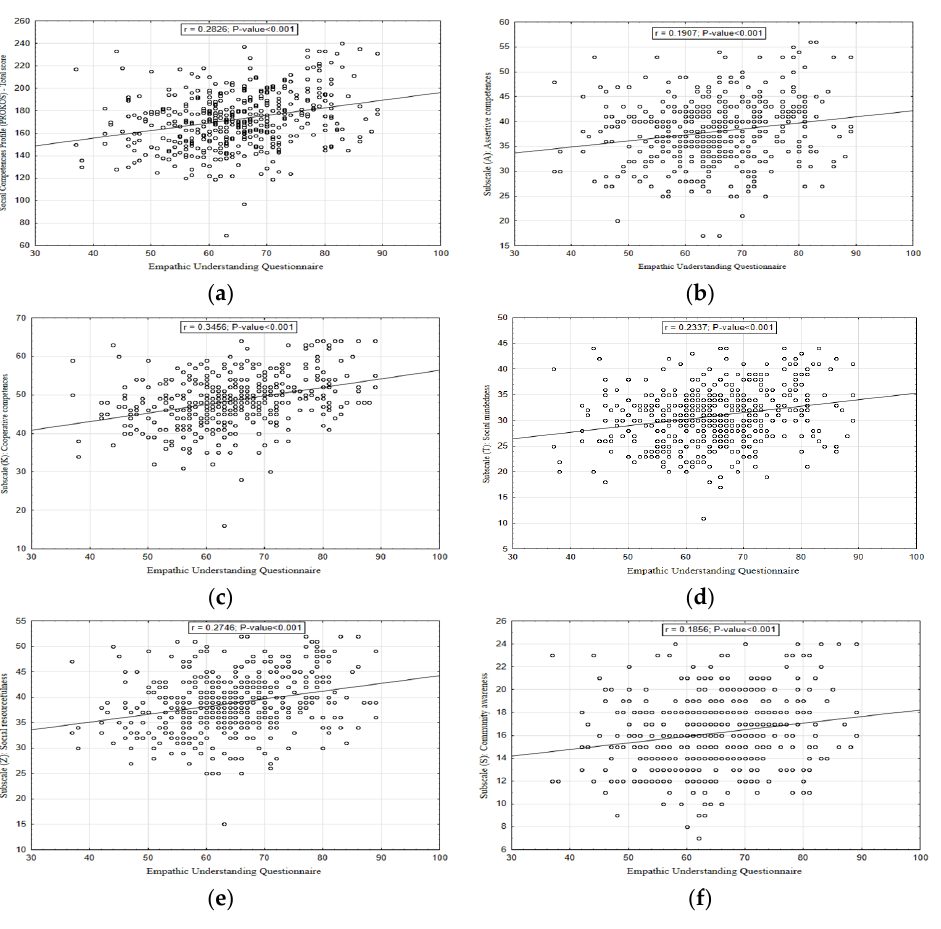
Figure 3. Relationships between Social Competences Profile and Empathic Understanding Question- naire: ( a ) Social Competences Profile (PROKOS): Total score; ( b ) Subscale (A): Assertive competences; ( c ) Subscale (K): Cooperative competences; ( d ) Subscale (T): Social mindedness; ( e ) Subscale (Z): Social resourcefulness; ( f ) Subscale (S): Community awareness.